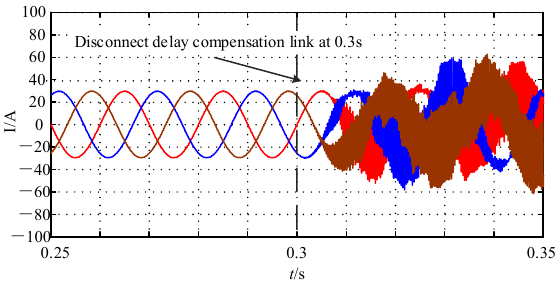
Figure 10. Switching of delay compensation link in strong grid.